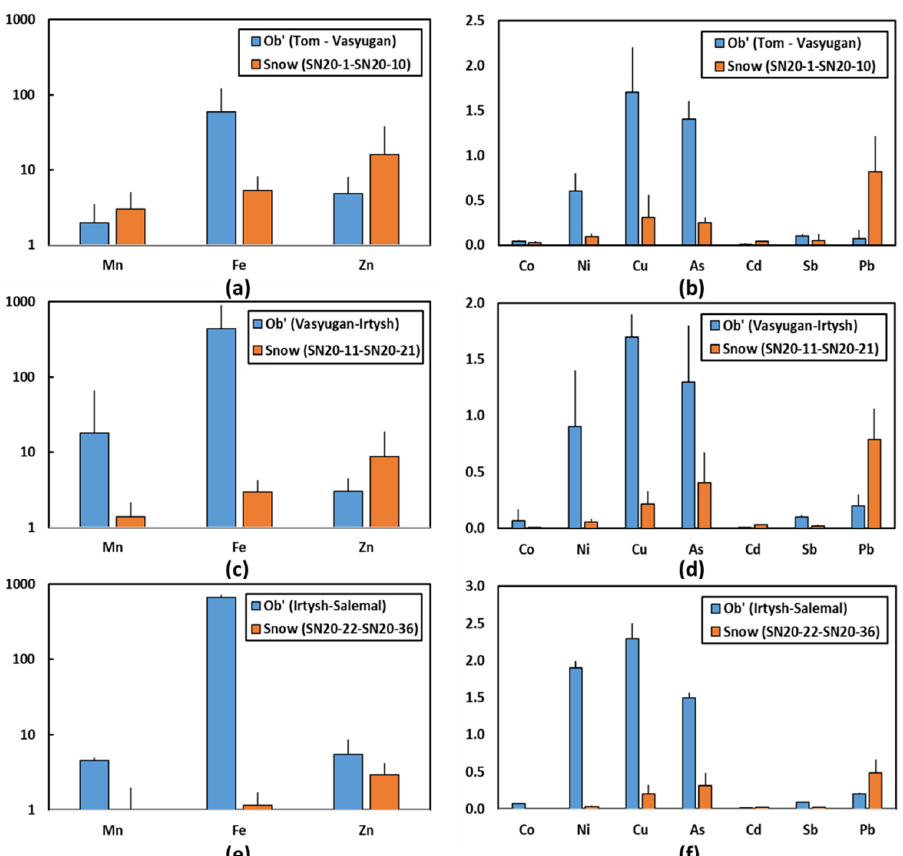
Figure 5. Histogram of metal concentrations in snow and river water (mean ± sd) of Western Siberia: ( a ) concentration of Mn, Fe, and Zn (SN20-1–SN20-10); ( b ) concentration of Co, Ni, Cu, As, Cd, Sb, and Pb (SN20-1–SN20-10); ( c ) concentration of Mn, Fe, and Zn (SN20-11–SN20-21); ( d ) concentration of Co, Ni, Cu, As, Cd, Sb, and Pb (SN20-11–SN20-21); ( e ) concentration of Mn,